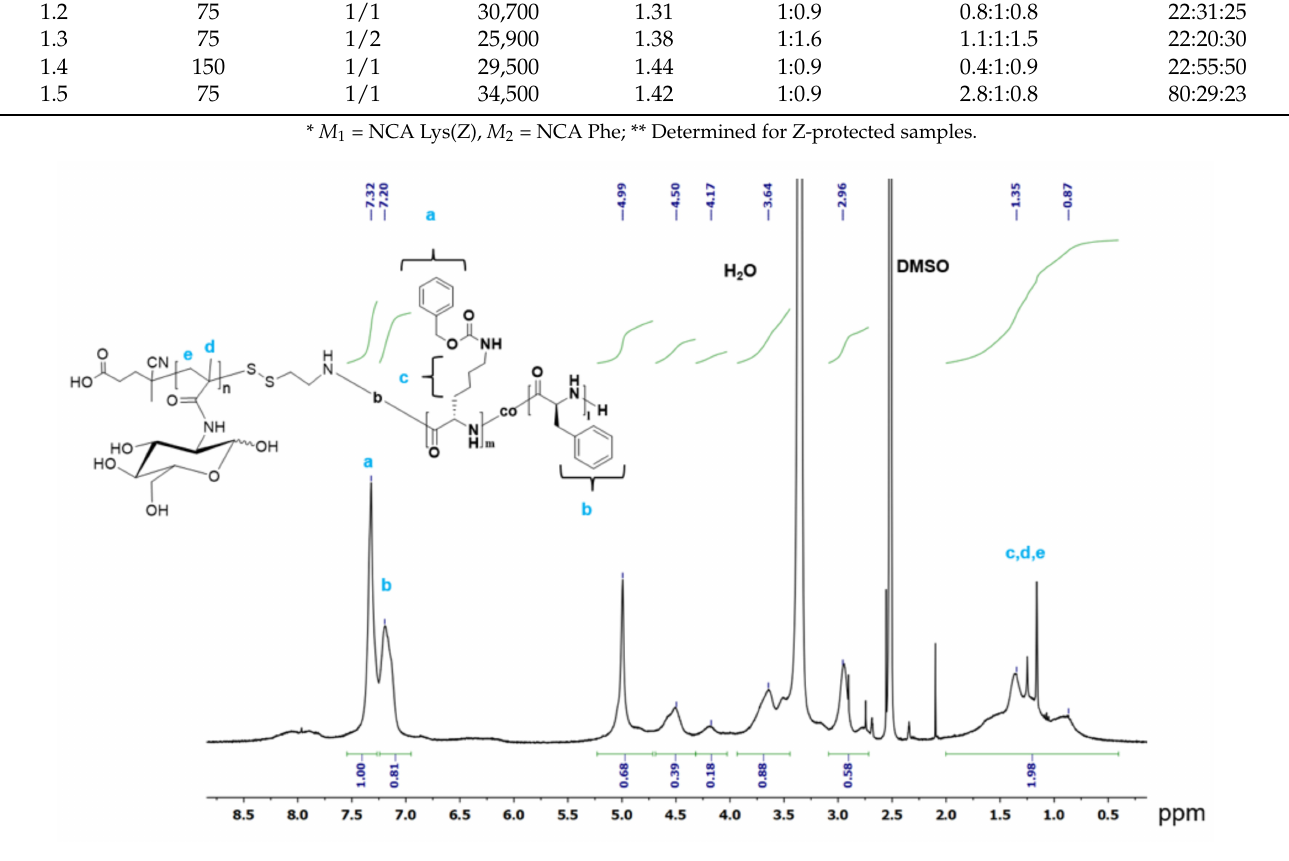
Figure 2. 1 H NMR spectrum of PMAG- b -P(Lys(Z)- co -Phe) (sample #1.2). The synthesis of oxidized glycopolymer was carried out using a sample of PMAG containing 22 monomer units ( M n = 10,700, Ð = 1.09). For the preparation of functionalized PMAG, its dithiobenzoate end-group was removed by reduction with NaBH 4 , followed by dimerization of the polymer in the presence of iodine (Figure 3). Dialdehyde derivatives (ox-PMAG) were then obtained via reaction with IO 4 − ion as described elsewhere [55]. The oxidation was performed at different molar ratios of NaIO 4 /MAG units to vary of aldehyde groups content.